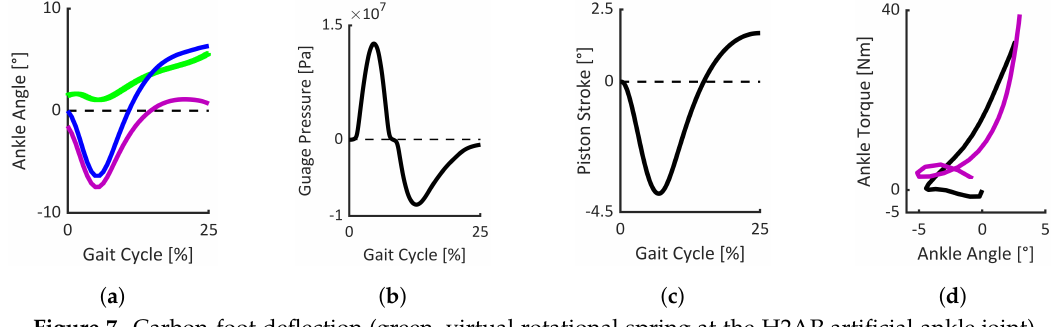
Figure 7. Carbon-foot deflection (green, virtual rotational spring at the H2AP artificial ankle joint) and required damper RoM (purple) derived from the sound ankle angle pattern (blue, 1.1m/s, [35]) ( a ), hydraulic line gauge pressure by adjusting the control valves’ diameter to the minimum possible diameter ( b ), piston stroke ( c ), and ankle torque-angle profile ( d ) during the first 25% of the gait cycle. The simulated H2AP, reference data, and ideal damper data are colored in black, blue, and purple,